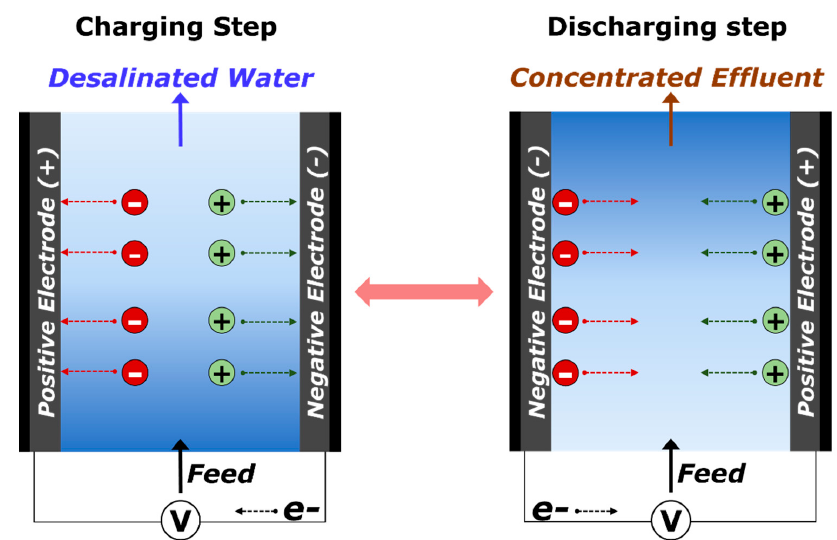
Figure 1. Schematic illustration of basic cell configurations and operations in capacitive deionization (CDI).